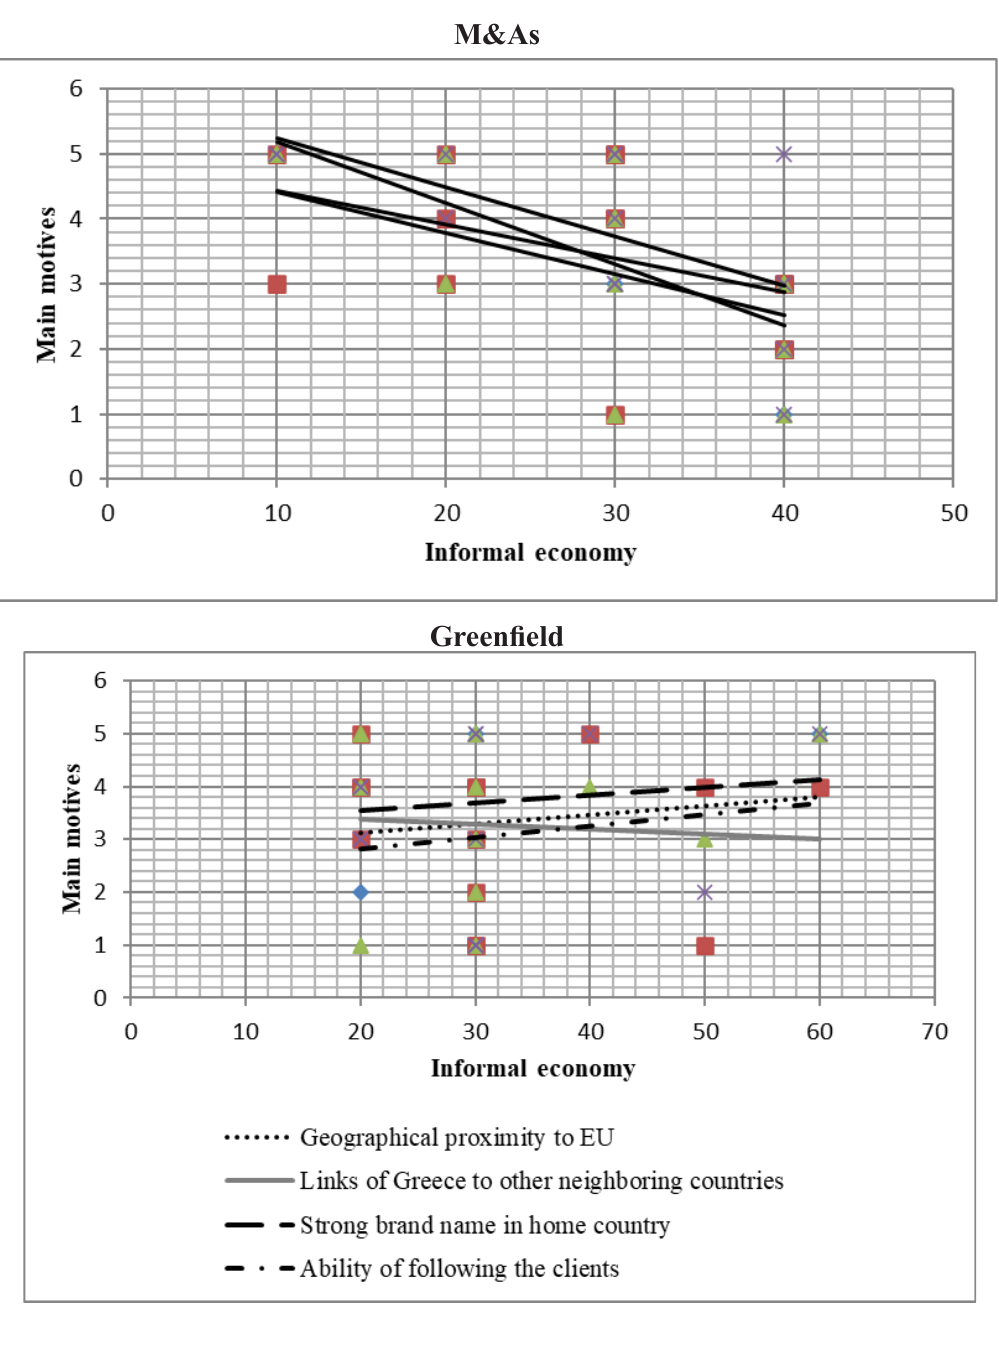
Figure 3: Main Motives to Invest in Greece by Types of Entry and Informal Economy M&As